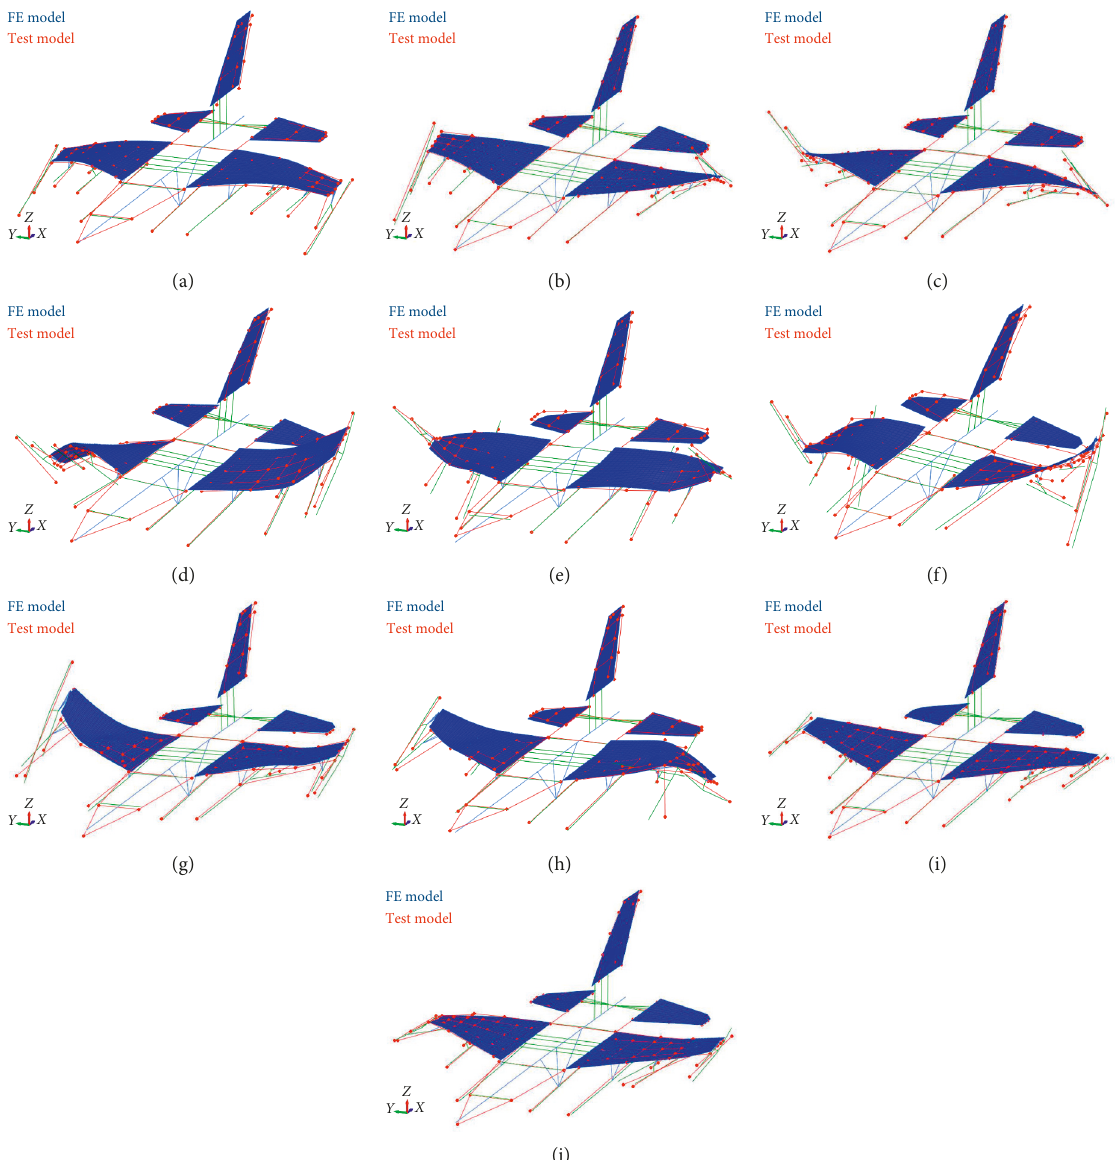
Figure 9: First 10 elastic modes (upper left to lower right): (a) mode 1, (b) mode 2, (c) mode 3, (d) mode 4, (e) mode 5, (f) mode 6, (g) mode 7, (h) mode 8, (i) mode 9, and (j) mode